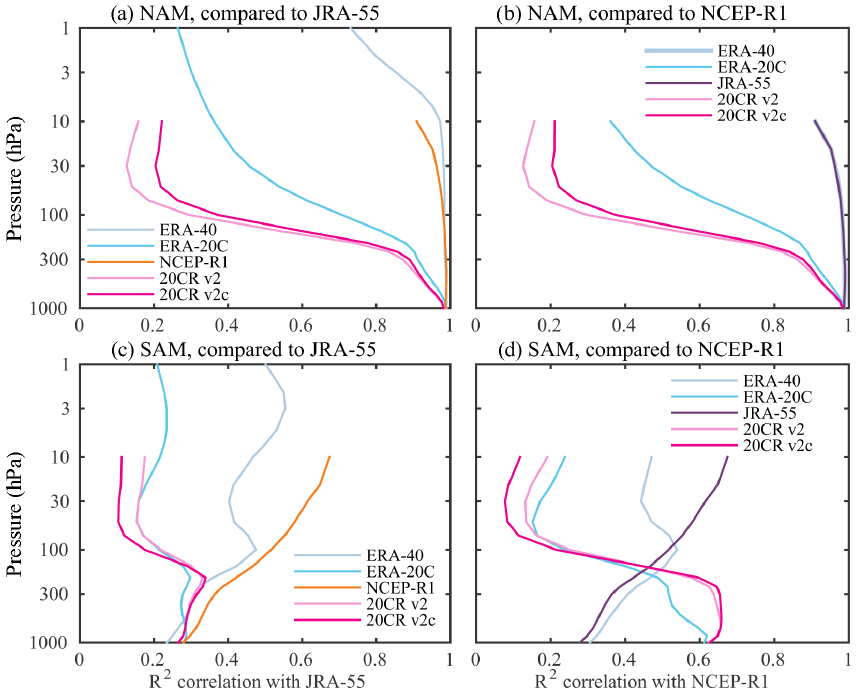
Figure 7. The squared correlation between (a, b) Northern and (c, d) Southern Annular Mode indices in various reanalyses with (a, c) JRA-55 and (b, d) NCEP-R1 during the presatellite era,